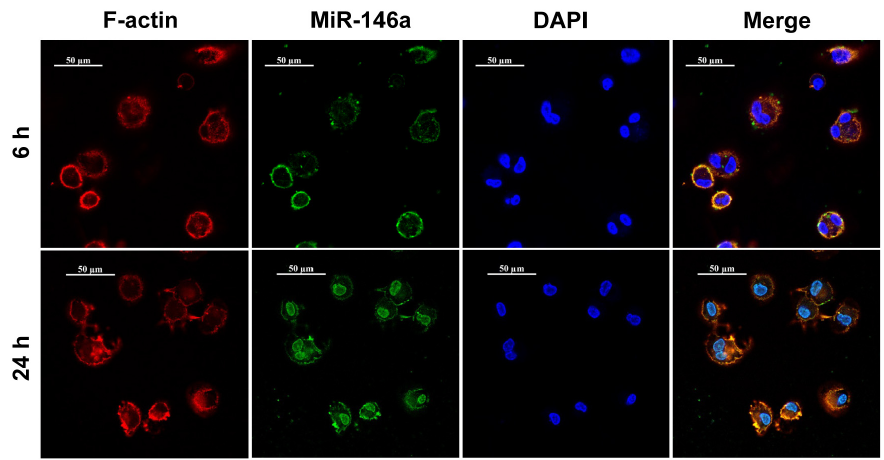
Figure 6. Dynamic uptake process of RALA-E/miR-146a in M1 macrophage 6 and 24 h after trans- fection.